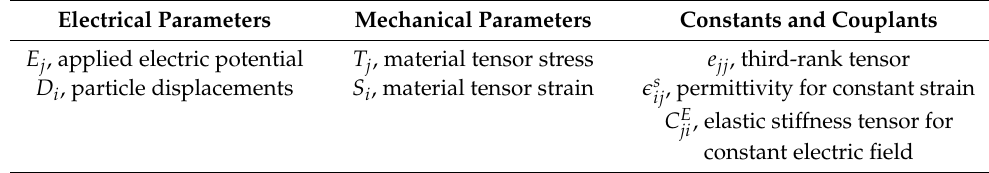
Table 1. Parameter